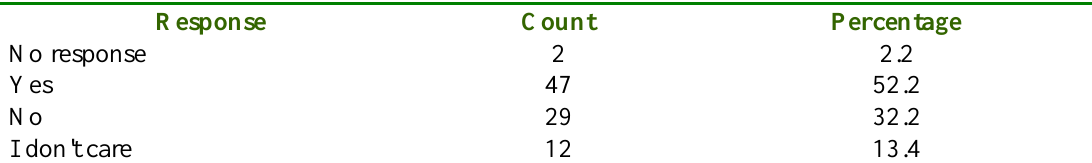
Table 7. Significance of Blackboard as the University’s Chosen